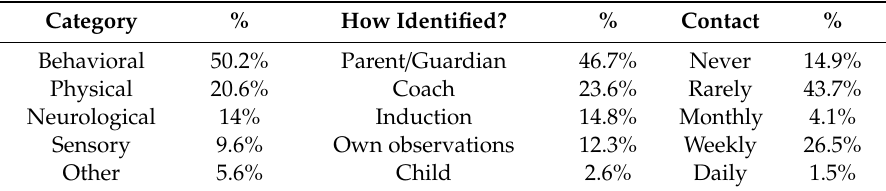
Table 2. Working with children who have a